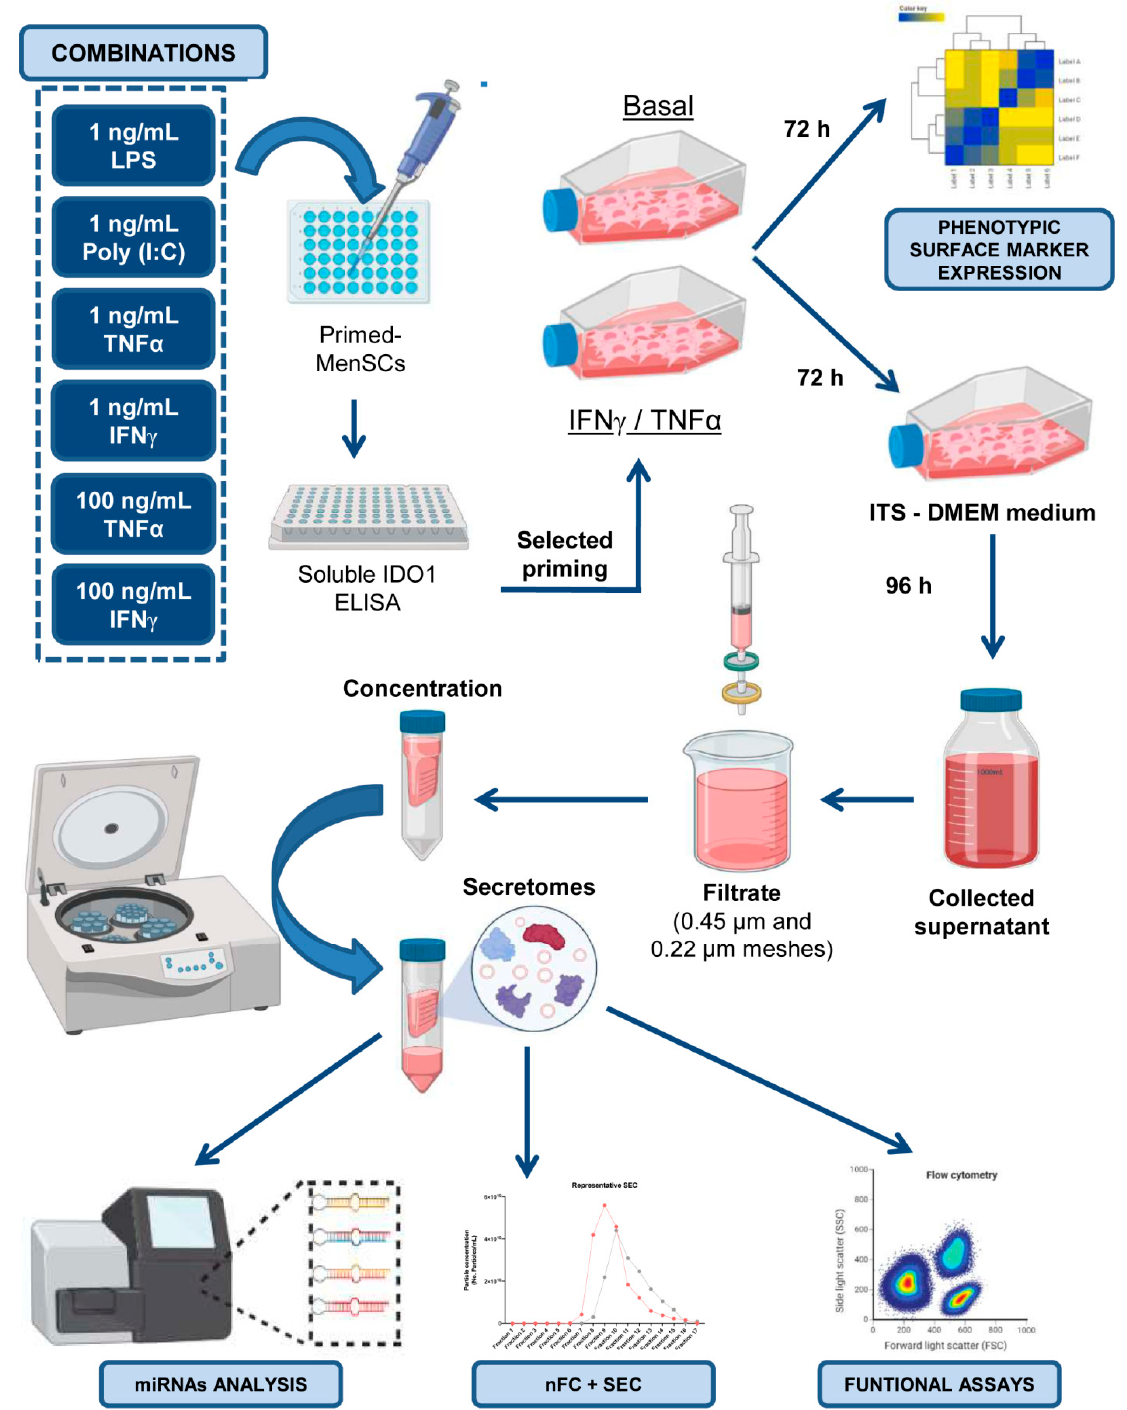
Figure 7. Graphic overview of key experimental procedures. LPS, Poly (I:C), TNF α , and IFN γ were used at different concentrations, individually or in combination, to prime in vitro cultured MenSCs. The optimal priming strategy was identified by ELISA in terms of IDO1 release. For the ELISA results, the MenSCs were primed with 100 ng/mL IFN γ and TNF α , and the phenotypic profiles of MenSCs* and MenSCs were determined by flow cytometry. Moreover, the MenSCs and MenSCs* were cultured with ITS (insulin-transferrin-selenium)-DMEM medium serum-free. After 96 h, conditioned media were concentrated to obtain the total secretome fraction, which was also enriched in extracellular vesicles. Finally, these secretomes were characterized by next-generation sequencing (NGS), nano-flow cytometry in combination with size exclusion chromatography (nFC+ SEC), as well as with lymphocyte activation assays. Images have been created with BioRender